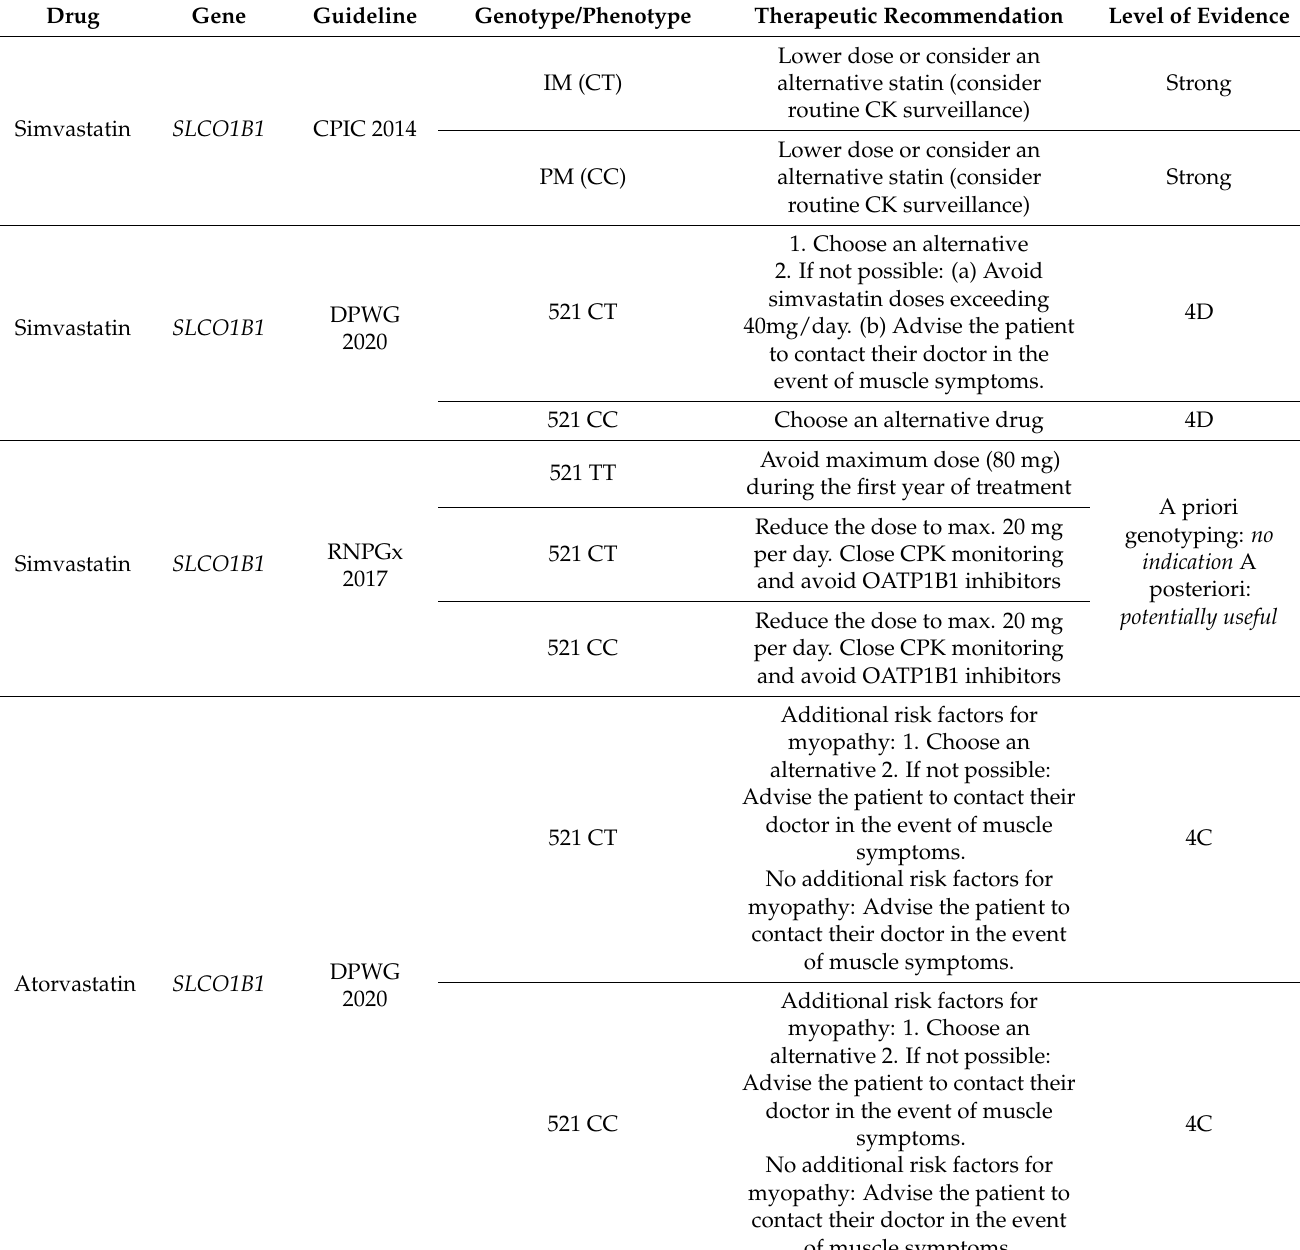
Table 4. Drug-gene pairs and dose recommendations by different clinical guidelines.